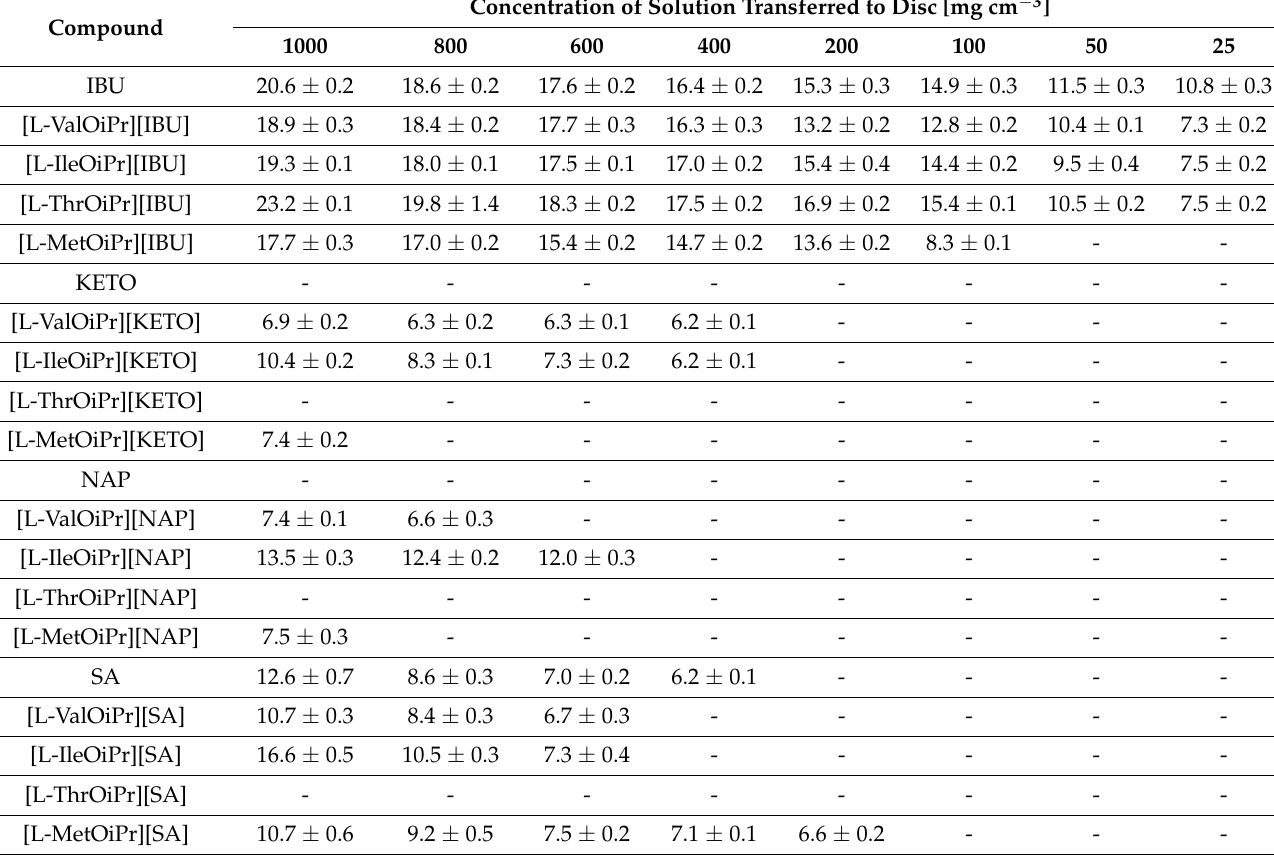
Table 7. Antimicrobial activity against Staphylococcus epidermidis of acids from NSAIDs and their L-amino acid isopropyl esters salts, Inhibition diameter